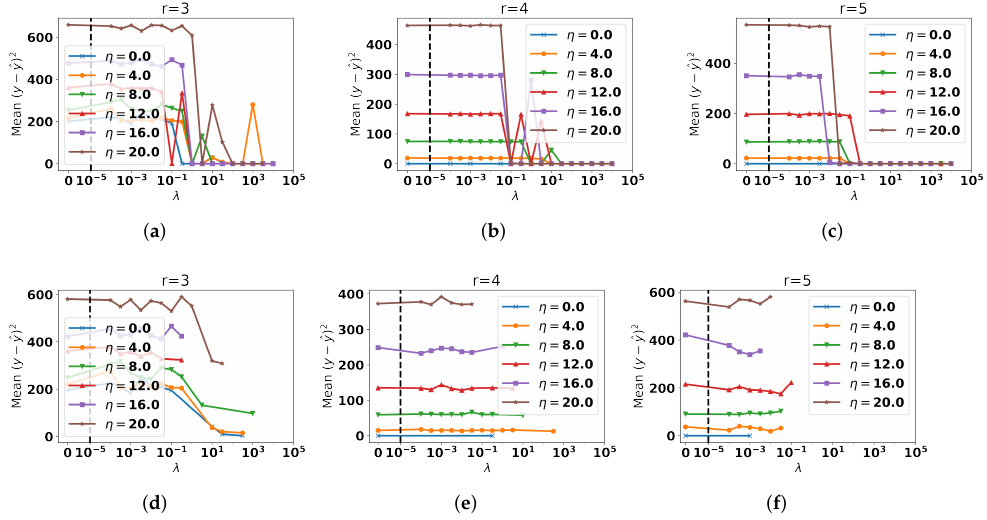
Figure 3. Regression errors at various noise levels η with varying regression weight λ . The true number of topics is r = 4. The top row, ( a – c ), depicts the training errors, and the bottom row, ( d – f ), depicts the testing errors. The first column, ( a , d ), is for a low rank approximation r = 3, the second column, ( b , e ), is for an approximation of correct rank r = 4, and the third column, ( c , f ), is for when the number of topics used r = 5 is larger than the true number of topics. For each λ , η , and r , fifty trials were run, and the regression errors corresponding to the best overall objective function F ( λ ) were recorded. Points with λ > 0 for which the regression error exceeds 1.5 times the regression error at λ = 0 are not displayed. The dashed vertical line is the transition point between a linear and logarithmic x